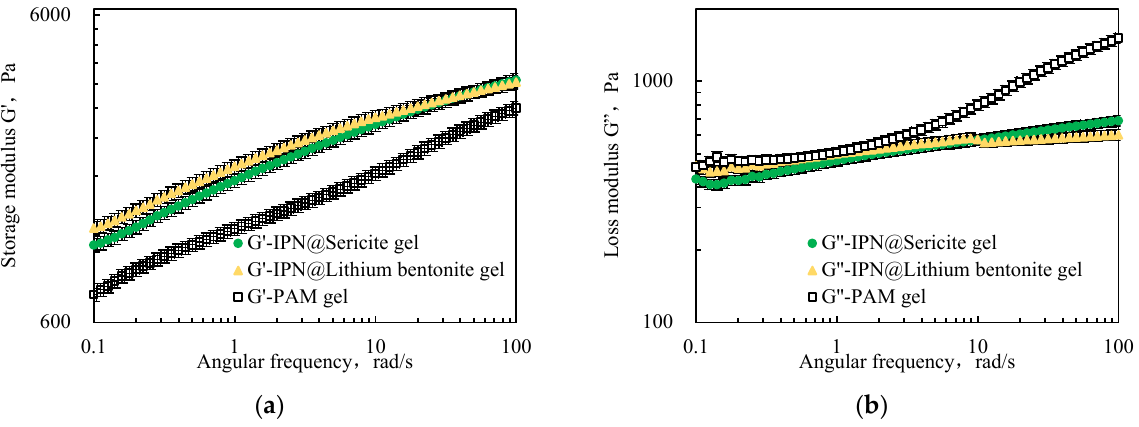
Figure 5. Comparison of ( a ) storage modulus G’ and ( b ) loss modulus G” of interpenetrating polymer networks.